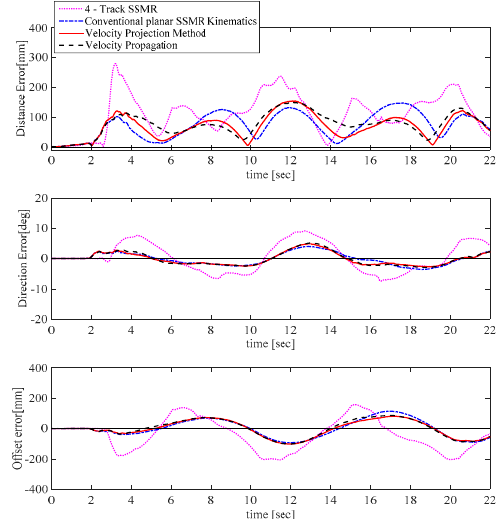
Figure 11. Comparison of maneuverability performances of the PASTRo in terms of the conventional SSMR kinematics, TTCA based driving velocity projection, and velocity propagation-based driving velocity projection methods on sinusoidal terrain: distance error, direction error, and offset error.